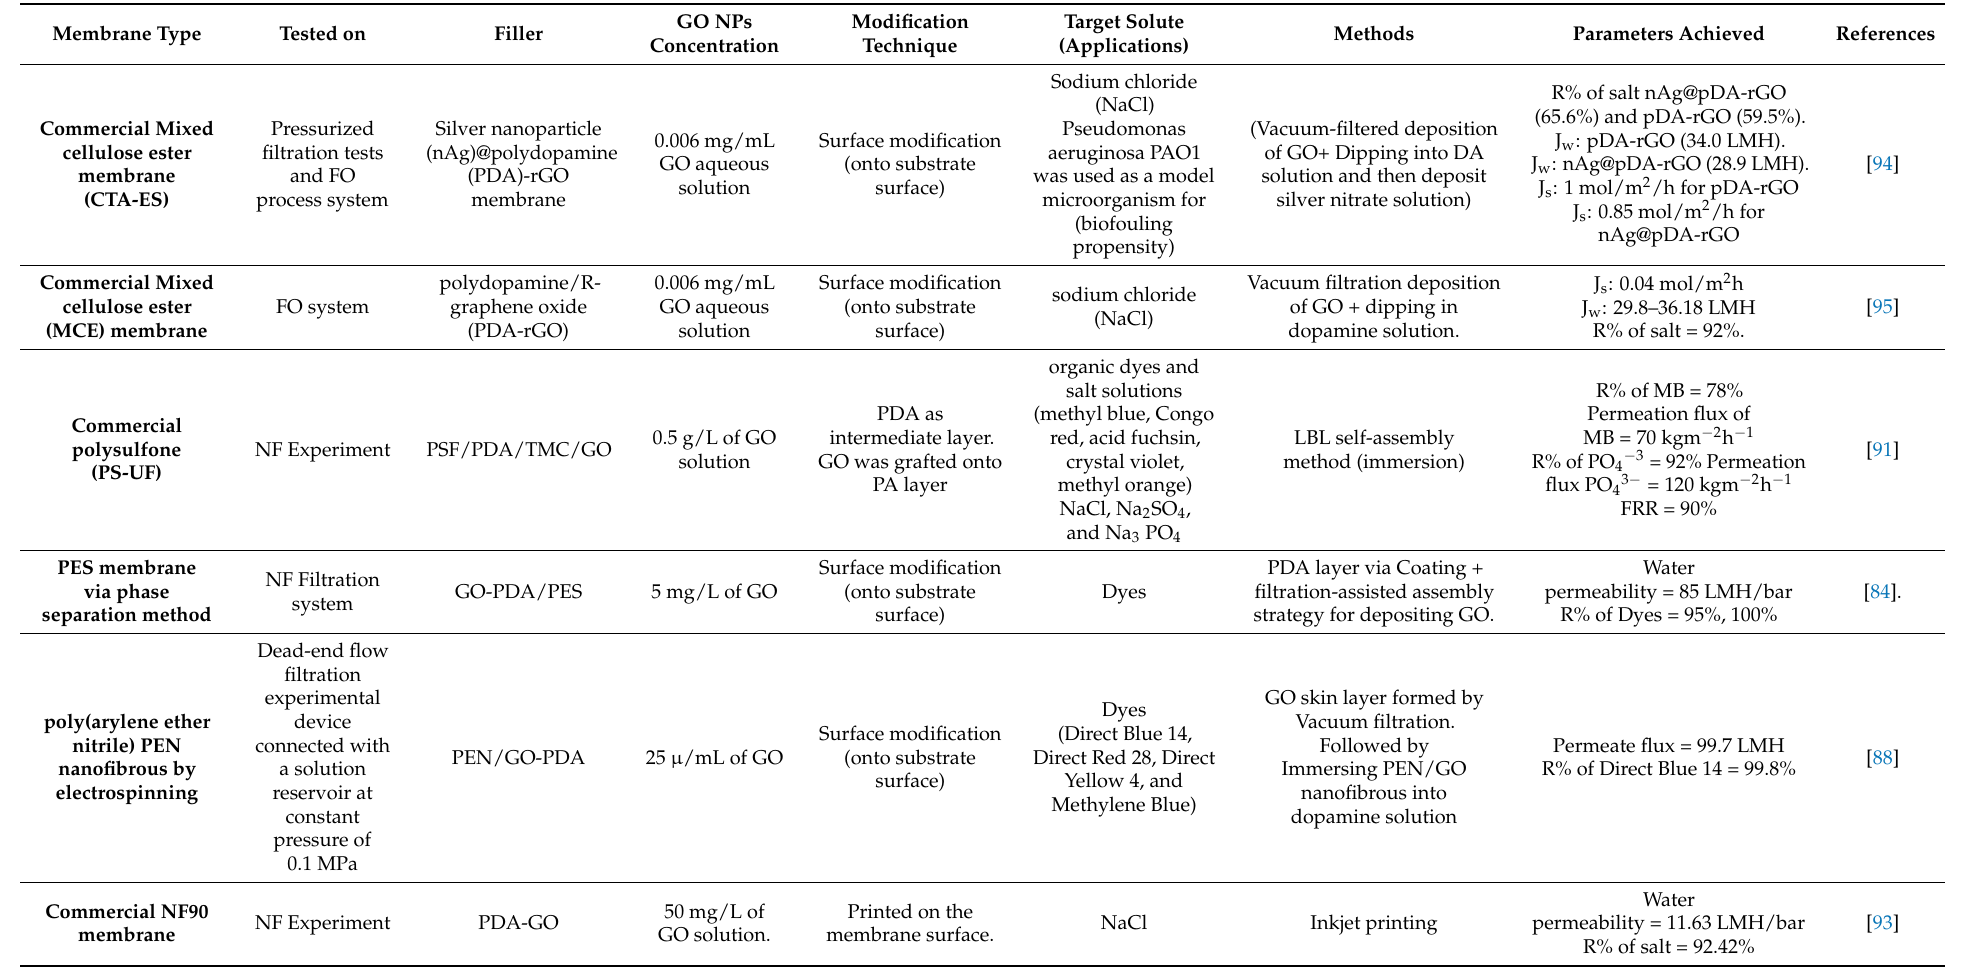
Table 4. Studies based on incorporation techniques of GO and PDA into different membranes